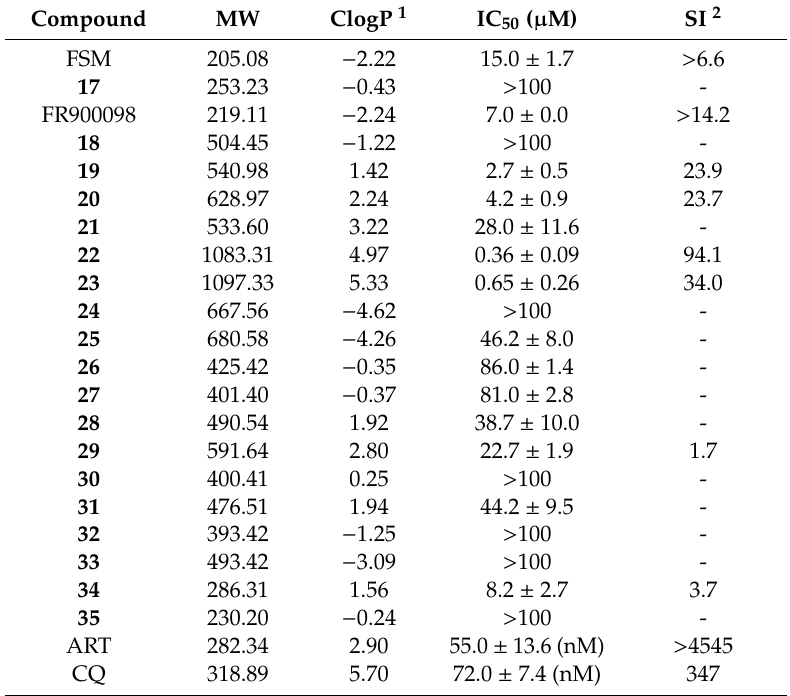
Table 1. Evaluation of antiplasmodial activities of synthesized compounds with